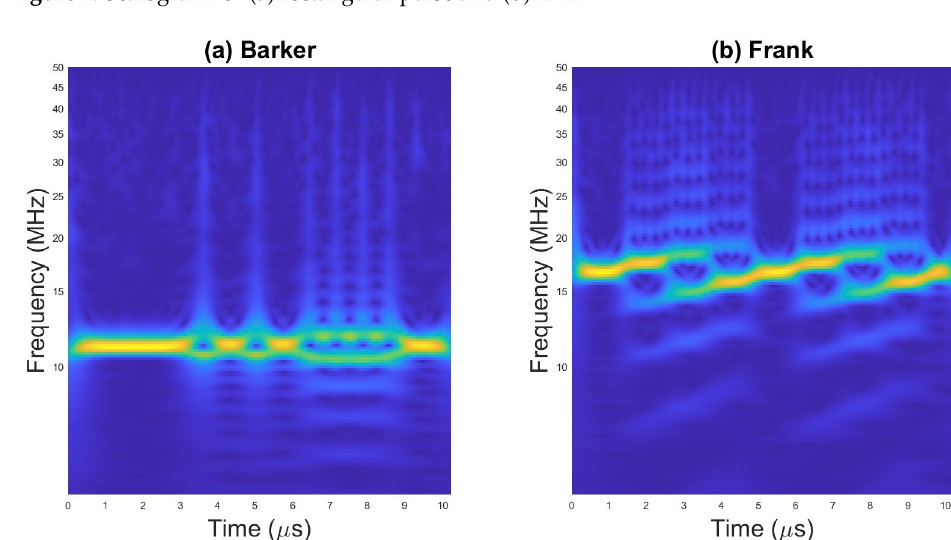
Figure 2. Scalogram for ( a ) rectangular pulse and ( b ) LFM.